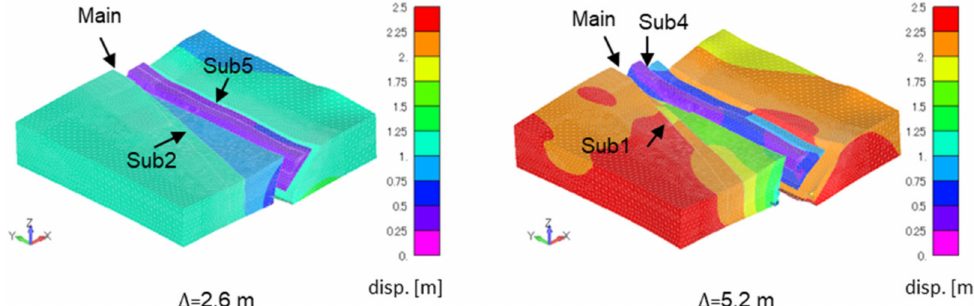
Figure 9. Contours of the displacement magnitude and deformation